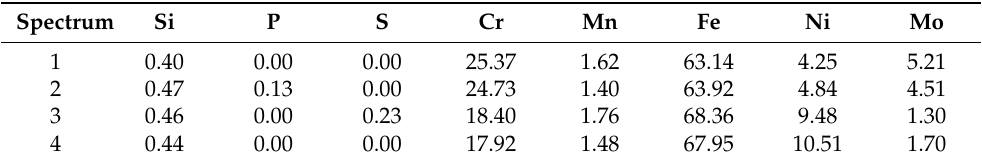
Figure 6. A representative SEM–EDS analysis of as-cast microstructure of SS2343 stainless steel. Table 2. EDS results in wt.% of the analyzed δ -ferrite (spectra 1, 2) and austenite (spectra 3, 4) in as-cast microstructure of SS2343 stainless steel.